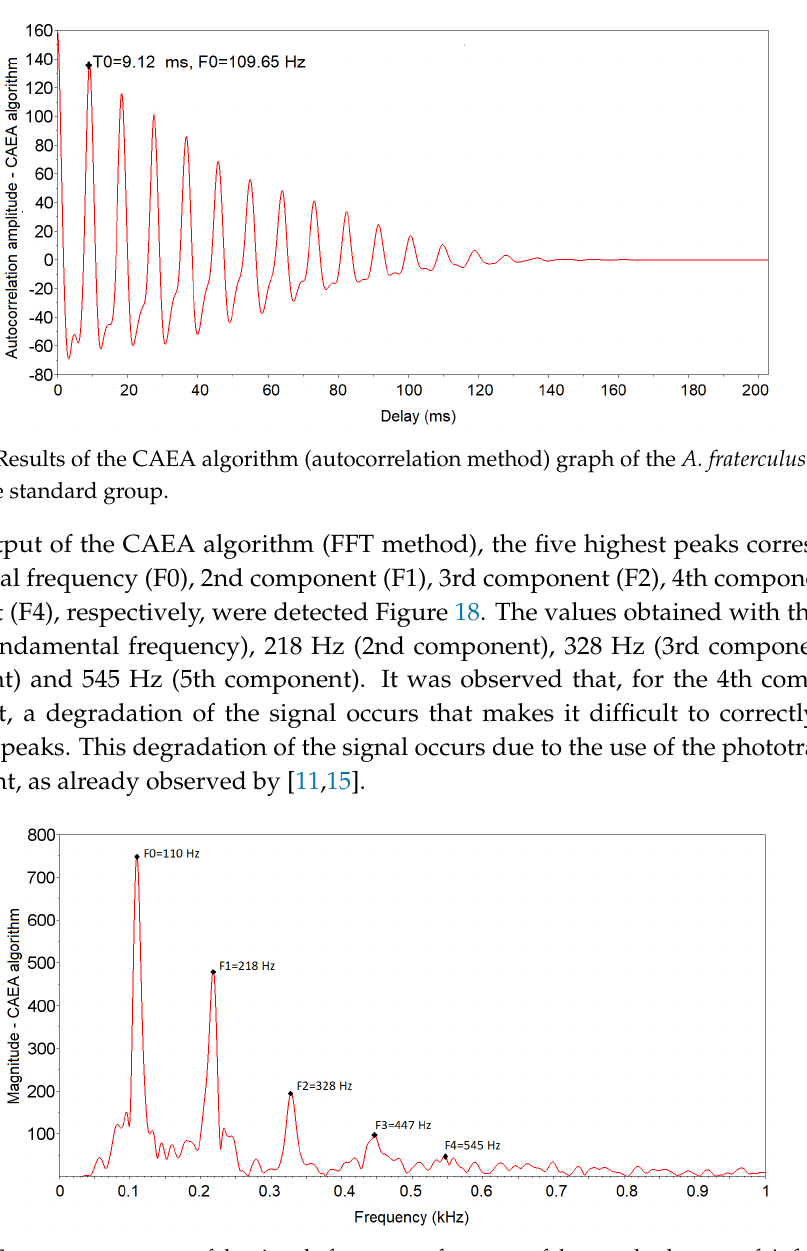
Figure 18. Frequency spectrum of the signal of an event of passage of the standard group of A. fraterculus obtained by the CAEA algorithm (FFT